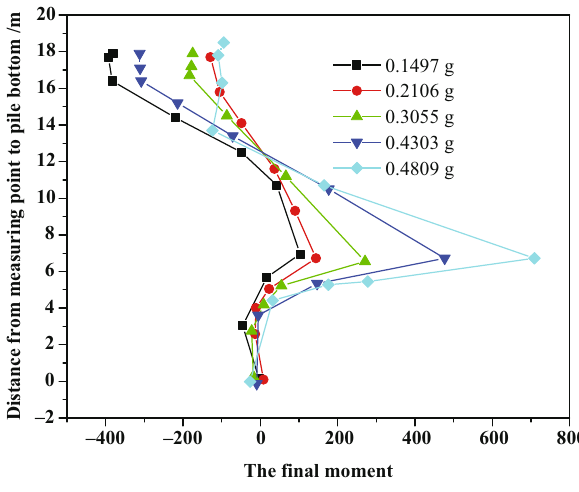
Figure 4: Final bending moment of P1 pile/ ( kN m ) .